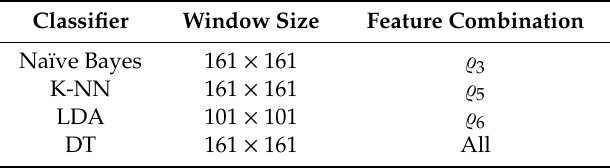
Table 9. Window size and subset of